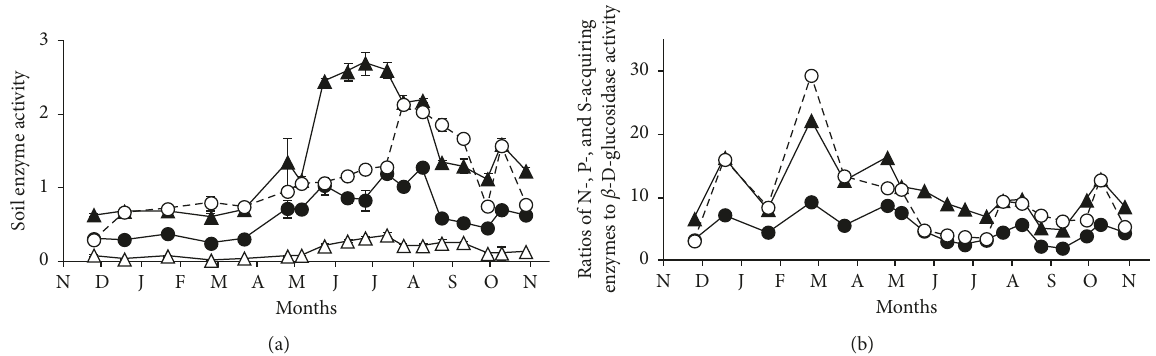
Figure 2: Annual variations in enzyme activities involved in C, N, P, and S cycling (a) and the ratios of N-, P-, and S-acquiring enzymes to β -D-glucosidase activity (b). (a) Filled triangle, arylsulfatase ( µ mol p-nitrophenol g circle, ratio of L-asparaginase to β -D-glucosidase activity; filled triangle, ratio of arylsulfatase to β -D-glucosidase activity; filled circle, ratio of acid phosphatase to β -D-glucosidase activity. Data points represent means, and the error bars represent standard